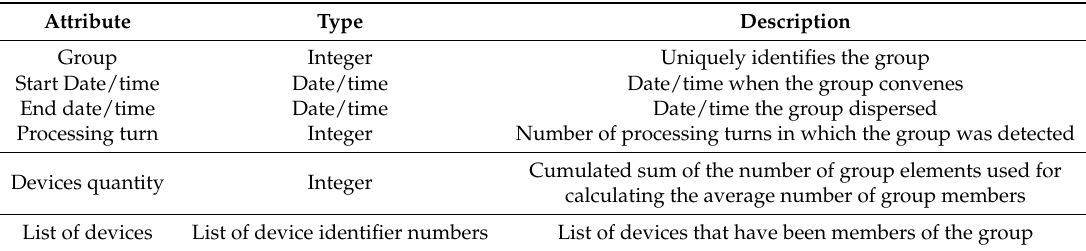
Table 2. Groups and risks: Algorithm 3 (detection of risks) output.